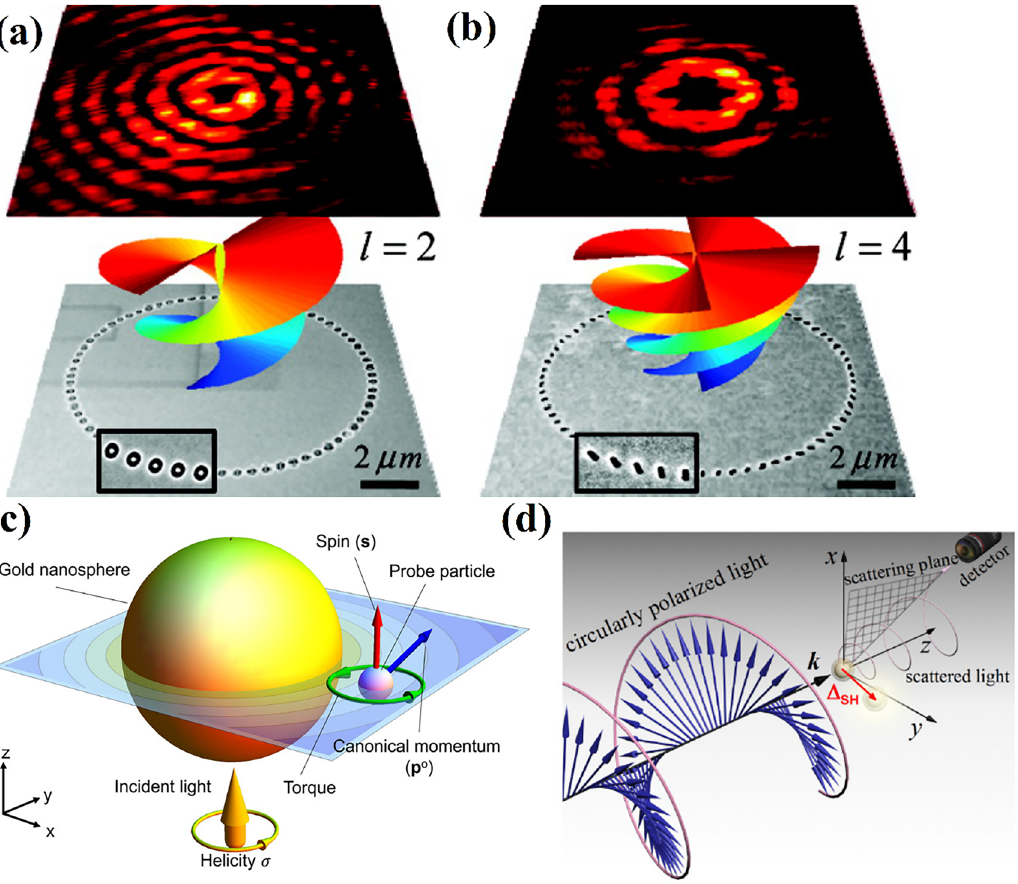
Figure 8: a, b, Far-field distribution of scattering spin-flip component in ordered and disordered ring chain structure [84]; Reproduced with permission. Copyright 2011, American Chemical Society. c, diagrammatic sketch of gold nanosphere scattering [108]; Reproduced with permission. Copyright 2017, American Chemical Society. d, SHE of scattering light from core – shell nanoparticles [109]. Reproduced with permission. Copyright 2019, Optical